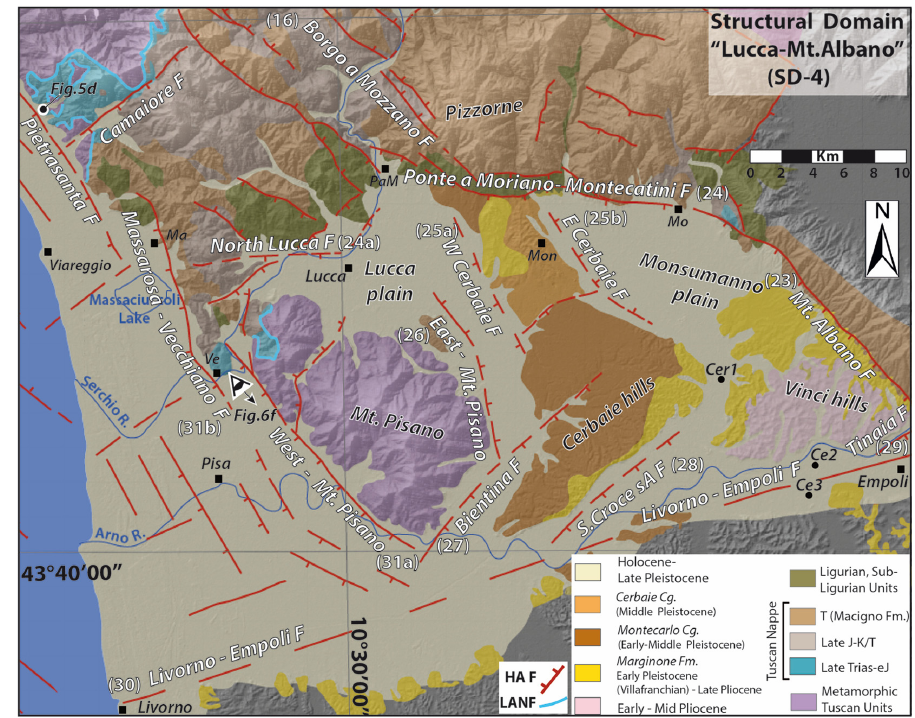
Figure 8. Major faults and geology in structural domain SD4 (Lucca–Mt. Albano). The map is derived from [92–94] and our work. Fault identification numbers as reported in Table S1. HAF: steep normal faults; LANF: low-angle